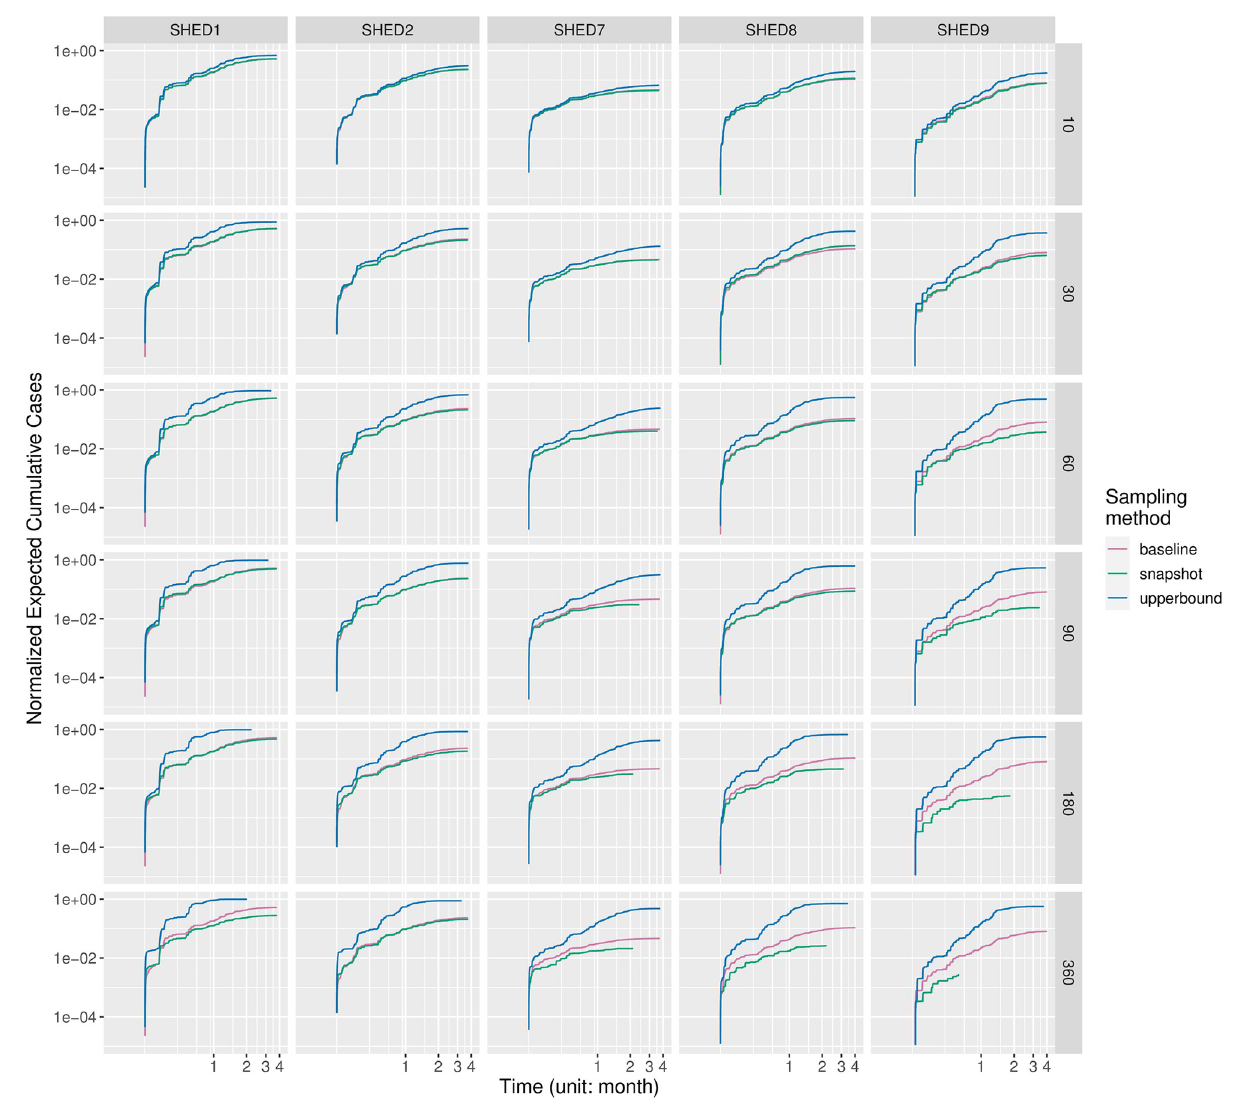
Fig 5. Outbreak timing of